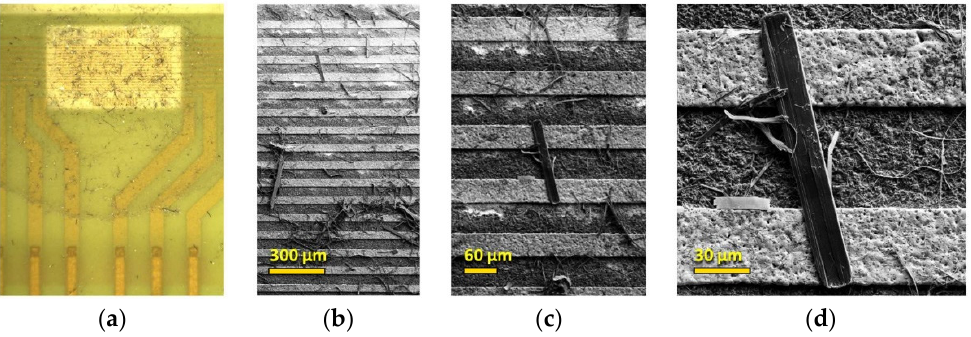
Figure 5. Microscopic characterization of the TiS 3 NW mat deposited on the multielectrode chip. ( a ) Optical photograph of the chip surface. ( b – d ) SEM images of the NW mat on a substrate with gold electrodes (bright horizontal stripes) at various magnifications.